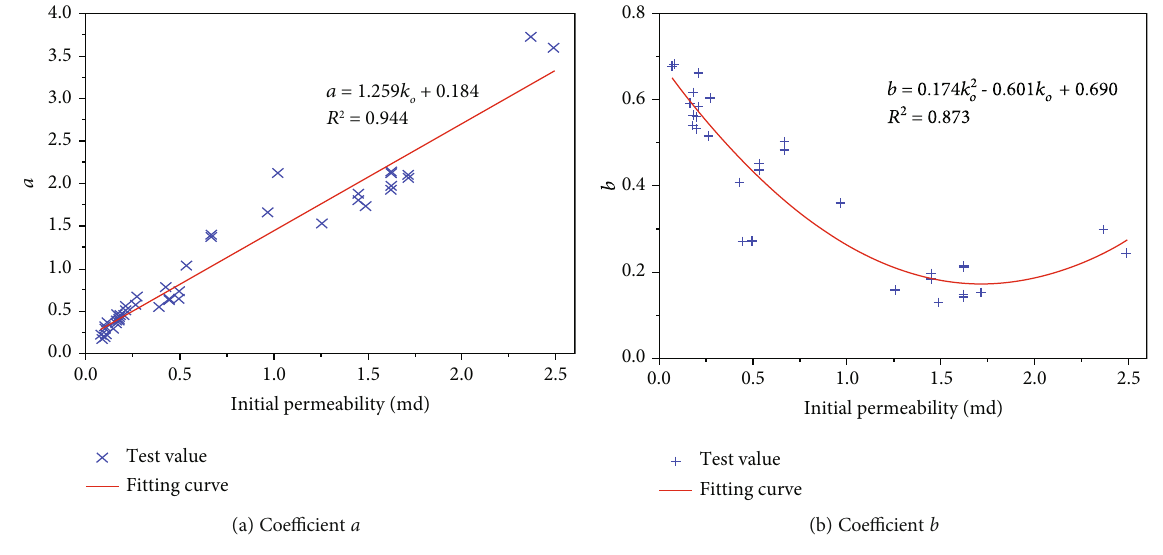
Figure 8: Coe ffi cients a and b with variation of initial